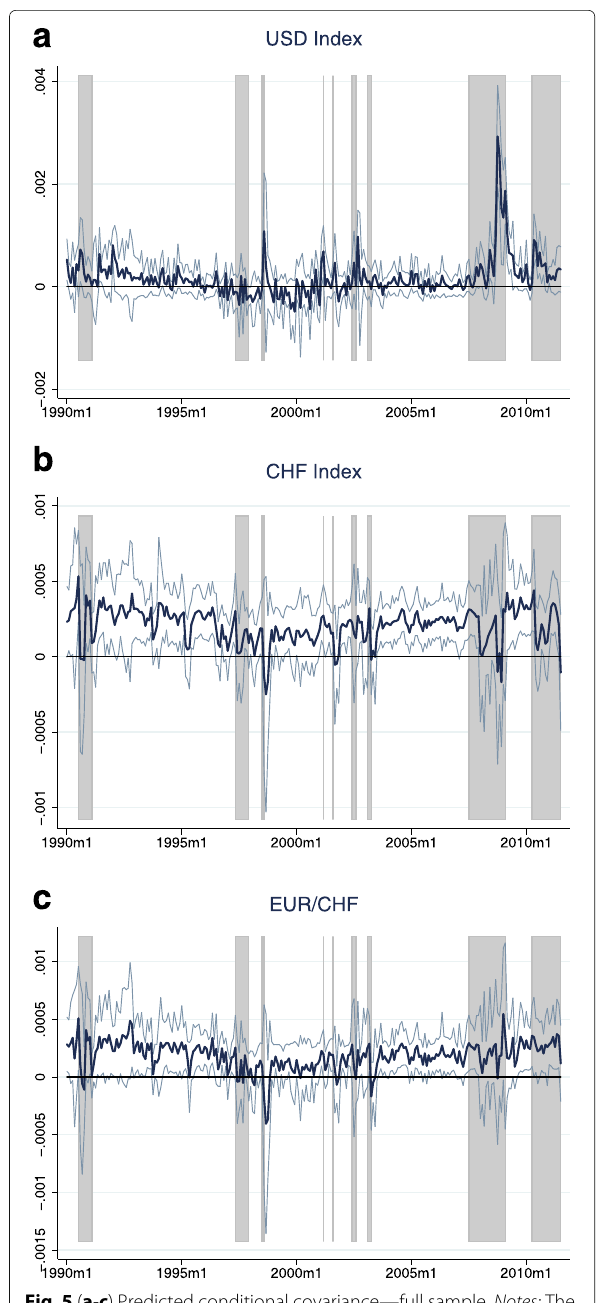
Fig. 5 ( a - c ) Predicted conditional covariance—full sample. Notes: The estimates of the conditional covariance correspond to the fitted value (cid:6) (cid:7) = ˆ α r ω t + 1 , (cid:2) e t + 1 of the first stage regression: (cid:13) Cov t Z Z t (see Eq. (9)). In this first stage regression, the ex-post covariance obtained from the zero stage regressions is regressed on a set of instruments. The set of instruments Z t consists of a constant, the dividend-price ratio, the lagged equity return, plus a measure for the lagged equity return variance, exchange rate return variance, and their covariance. The first-stage regression is estimated using the full sample, which consists of 259 observations. The two thin lines represent the 95% confidence band and are based on a two sided t-statistic with Newey-West estimates of the standard